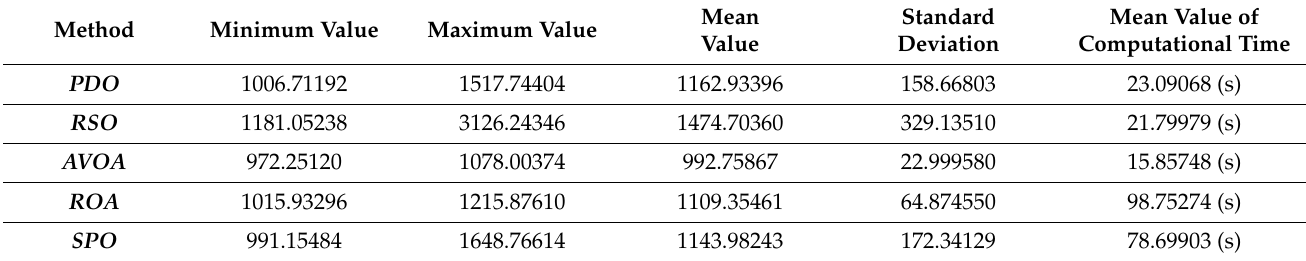
Table 11. Statistical analysis for proposed algorithms with case